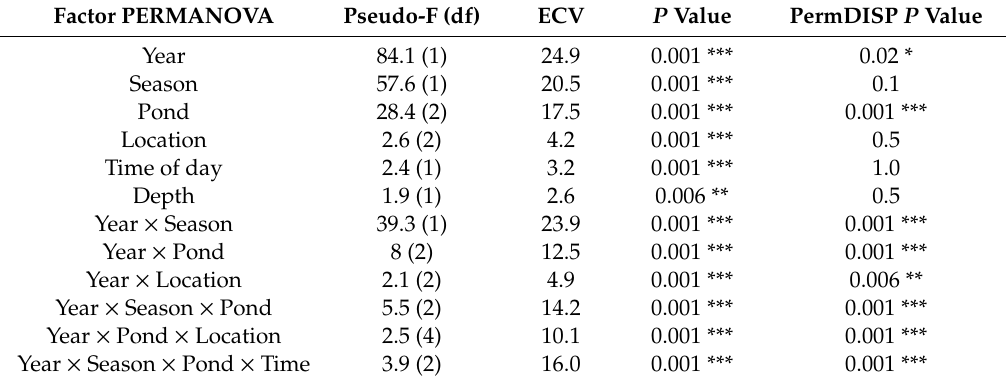
Figure 2. Non-metric multidimensional scaling (nMDS) of Sanderson bacterial community according to the ‘Year’ (2012 and 2013), ‘Season’ (Wet and Dry) and ‘Pond’ factors. P1 = Pond 1, P2 = Pond 2 and P5 = Pond 5. 2D Stress value 0.19. Table 1. Permutational analysis of variance (PERMANOVA) analysis, testing the di ff erences in taxa between year (2012, 2013), season (early wet and dry), pond number (P1, P2 and P5), location within the ponds (inlet, middle and outlet), time of day (6 am and 1 pm) and depth of the water sampled (surface and benthic). The designation “df” refers to degrees of freedom, “ECV” to the square root of estimates of components of variation indicating the e ff ect size as average% SV dissimilarity due to that factor (residual ECV 32.7). The P value is based on > 9700 unique permutations; “PermDISP” permutational distance-based test for homogeneity of multivariate dispersions for main factors. *** P value = 0.001; ** P value < 0.01; * P value < 0.05.